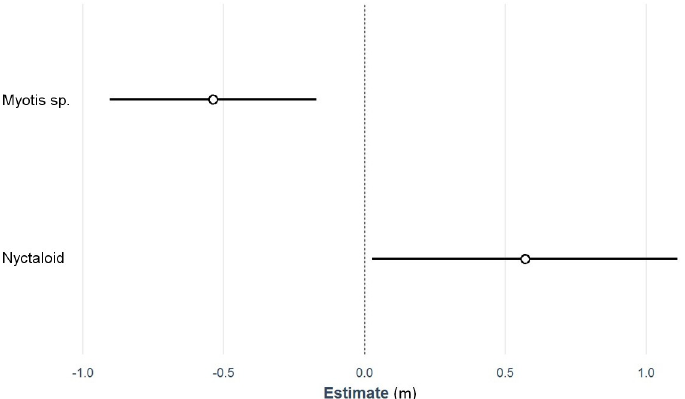
Fig 4. Results of the linear mixed model assessing minimum distance to the rotor dependent on the bat species. The respective site served as a random factor (n = 1,158). Circles indicate regression coefficients, and lines the 95% confidence intervals. The Pipistrellus group (dotted line) was defined as the reference.